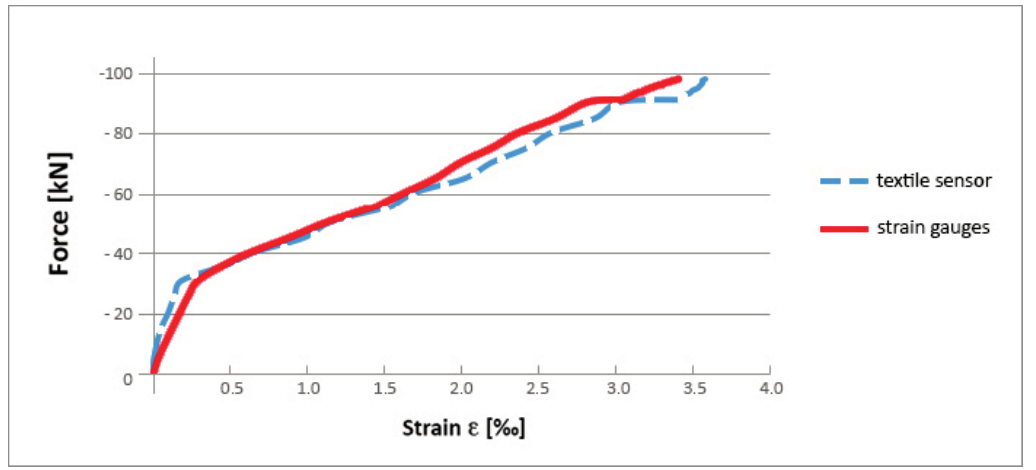
Figure 11. Comparison of averaged strain measured with textile sensor and with a set of nine conventional strain